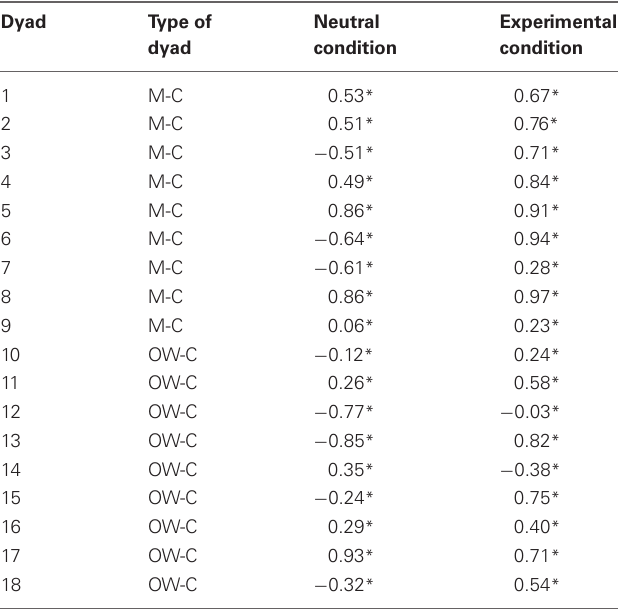
Table 3 | Pearson correlation coefficient for all the